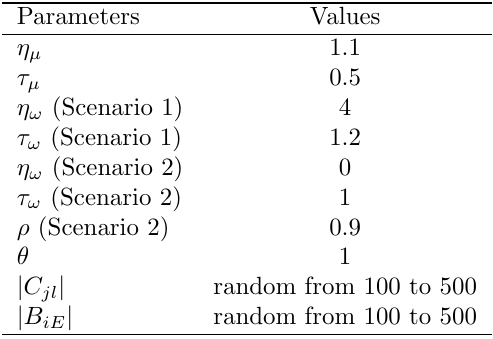
Values of the parameters for the generation of arti(cid:12)cial